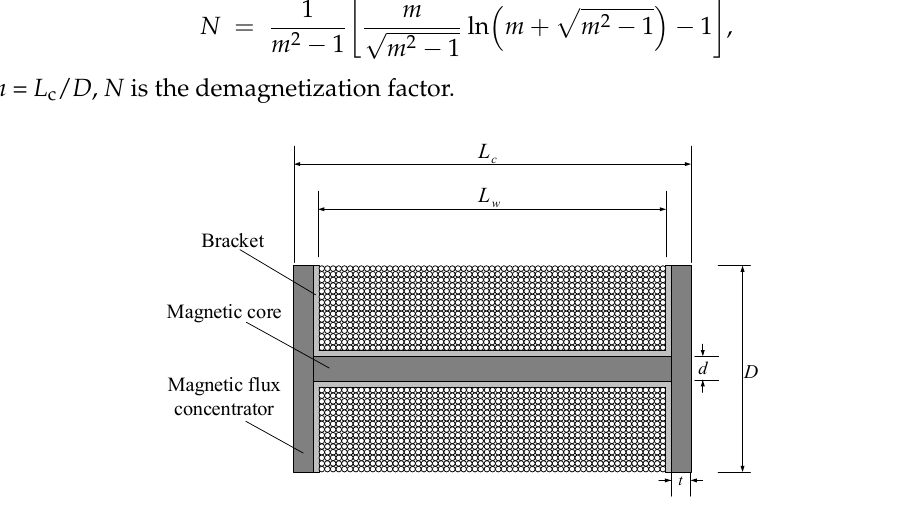
Figure 3. Structure of the improved magnetic core coil sensor.